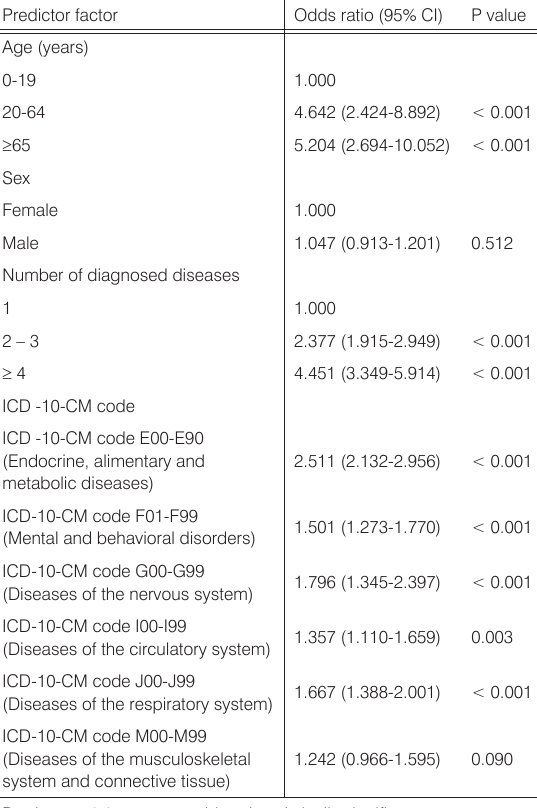
Table 4. Drug therapy characteristics associated with clinical significant potential drug-drug interactions Predictor